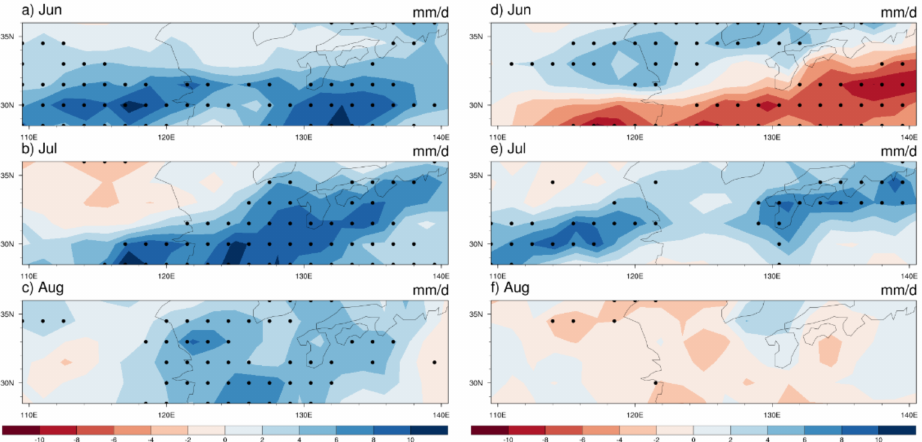
Figure 4. The spatial patterns for the precipitation difference between the five most positive years and the five most negative years ( a – c ) for the first time series (PC1) and ( d – f ) for (PC2). Stippled areas indicate the difference that exceeds the 90% confidence